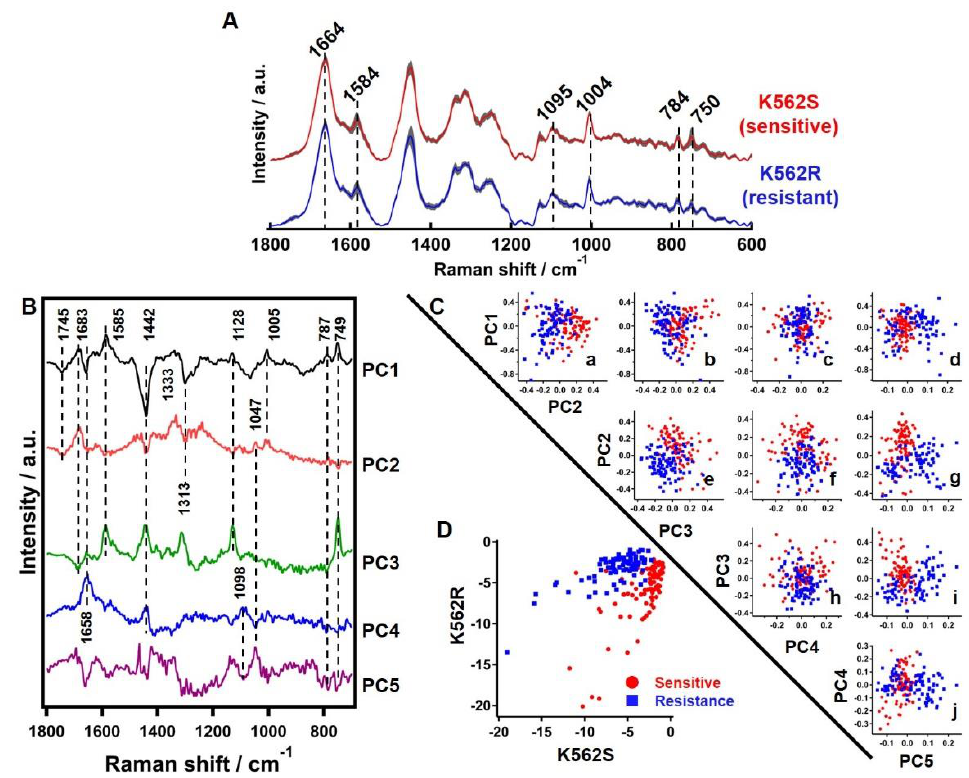
Figure 2. Comparison of average Raman spectra, PCA and LDA. ( A ) K562S (Red) and K562R (Blue) cell pellets along with their ± standard deviation (Grey). Some of the prominent bands observed in both are highlighted using dashed lines. ( B ) Discrimination of K562S and K562R cells by PCA. First 5 PC loadings’ spectra indicting molecular information. Contribution of each: PC1 (41%), PC2 (20%), PC3 (12%), PC4 (9%) and PC5 (3%). Dashed lines indicate some important bands useful for molecular identification. ( C ) PC scores scatter plot helpful to understand discrimination capability. (a) PC2, (b) PC3, (c) PC4 and (d) PC5 vs. PC1, respectively. (e) PC3, (f) PC4 and (g) PC5 vs. PC2, respectively. (h) PC4 and (i) PC5 vs. PC3, respectively. (j) PC5 vs. PC4. Red circles represent K562S cells and blue boxes represent K562R cells. ( D ) Linear discrimination factors of K562S and K562R cells are plotted by red circles and blue boxes, respectively.